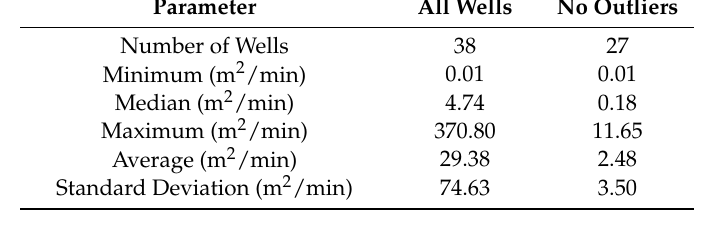
Table 3. Summary of pumping test-derived aquifer T values in the unconfined aquifer of Kilombero Valley from pumping tests carried out between June 2014 and December 2014.